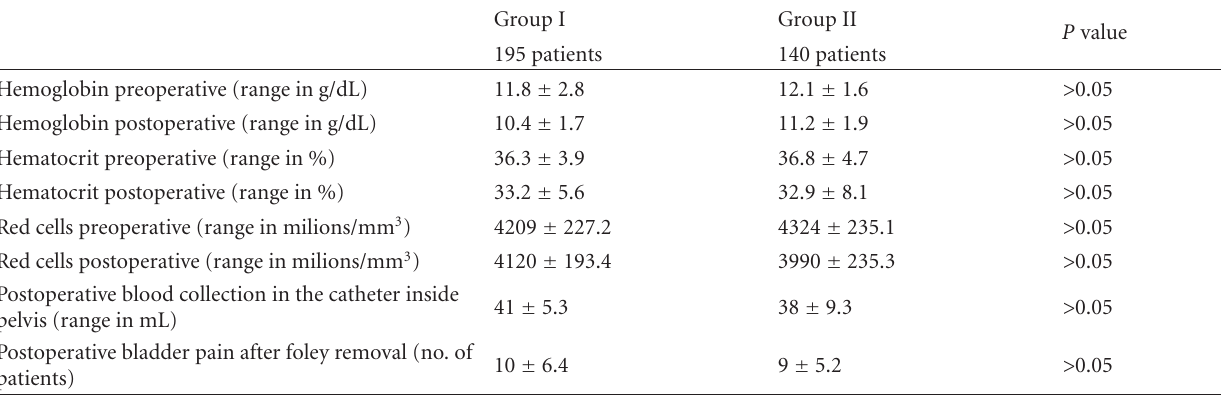
Table 3: Short-term complications after laparoscopic intracapsular